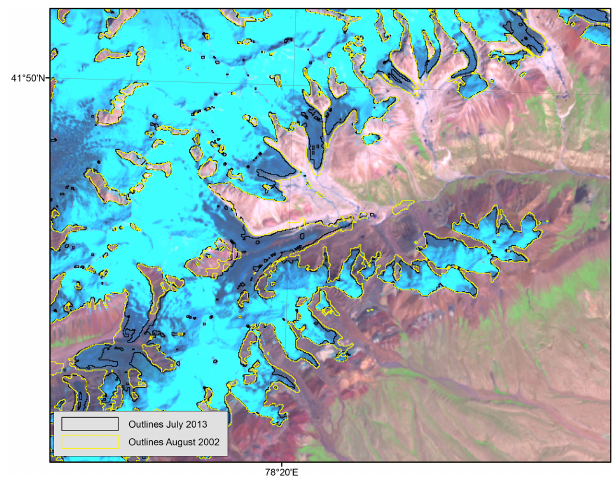
Figure 8. Algorithm outlines for July 2013 (black) and algorithm outlines for August 2002 (yellow), showing small retreats in glacier areas, particularly at the debris tongues. Vicinity of the Akshiirak glacierized massif, central Tien